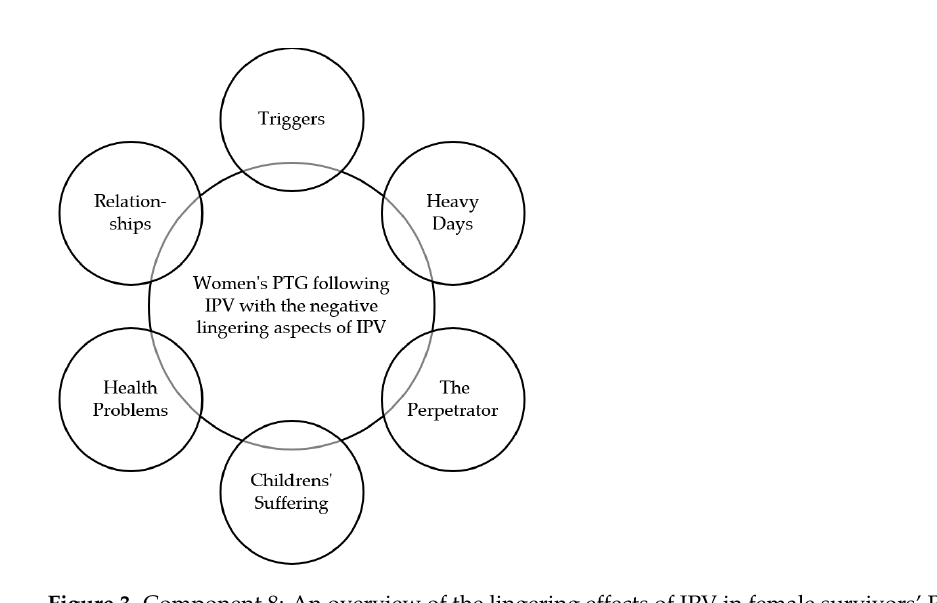
Figure 3. Component 8: An overview of the lingering effects of IPV in female survivors’ PTG. Note : The figure, developed by the authors for the present theory, shows the negative lingering effects of IPV affecting female survivors’ PTG. The figure illustrates women’s PTG following IPV in the middle of the figure, where the effects of IPV are lingering from the sides into the area of PTG. Despite the lingering effects of IPV, the survivors’ PTG seems to be strong, since the women enjoying PTG are not letting the effects of IPV overtake their PTG. They are aware of the lingering effects of IPV, know how to handle the situation, and are still enjoying PTG.